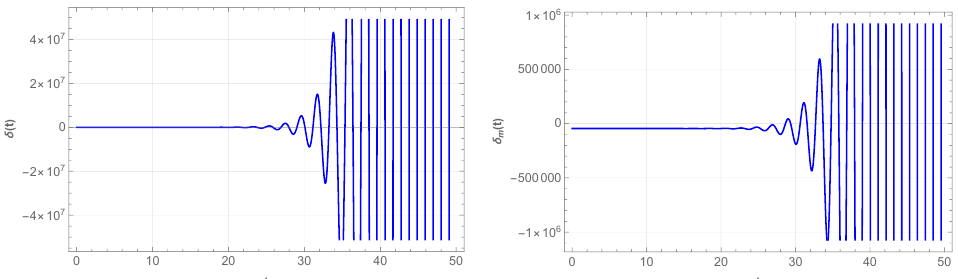
Figure 9. δ ( t ) ( left panel ) and δ m ( t ) ( right panel ) versus cosmic time for Model I. The parameter scheme: α = − 0.30, β = 0.15, χ = 0.15, ρ 0 =